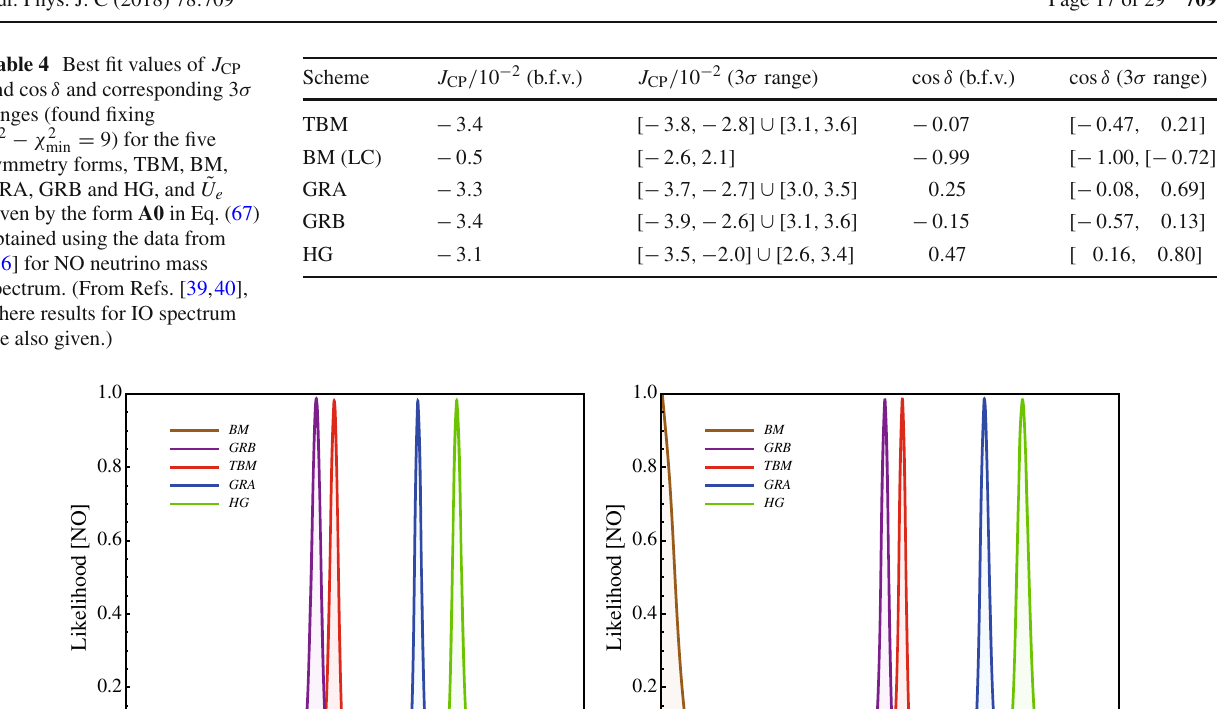
sian approximation. In the left (right) panel sin 2 θ 12 is set to its b.f.v. of [56] 0 . 308 (is set to 0 . 332), the other mixing angles being fixed to their NO best fit values taken from [56]. See text for further details. (From Ref.